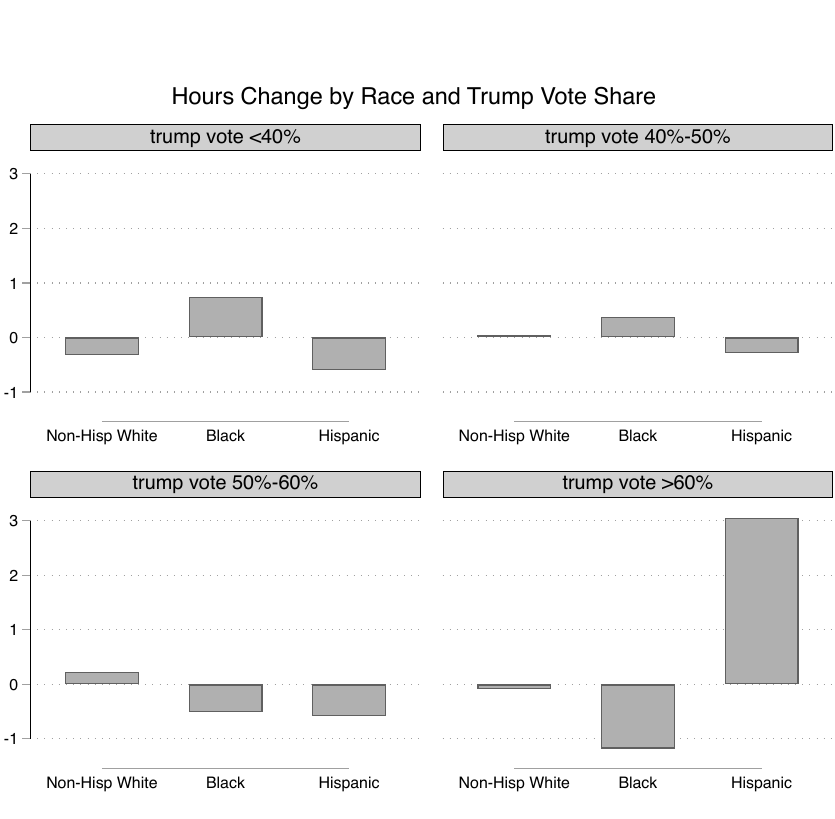
sociological science |